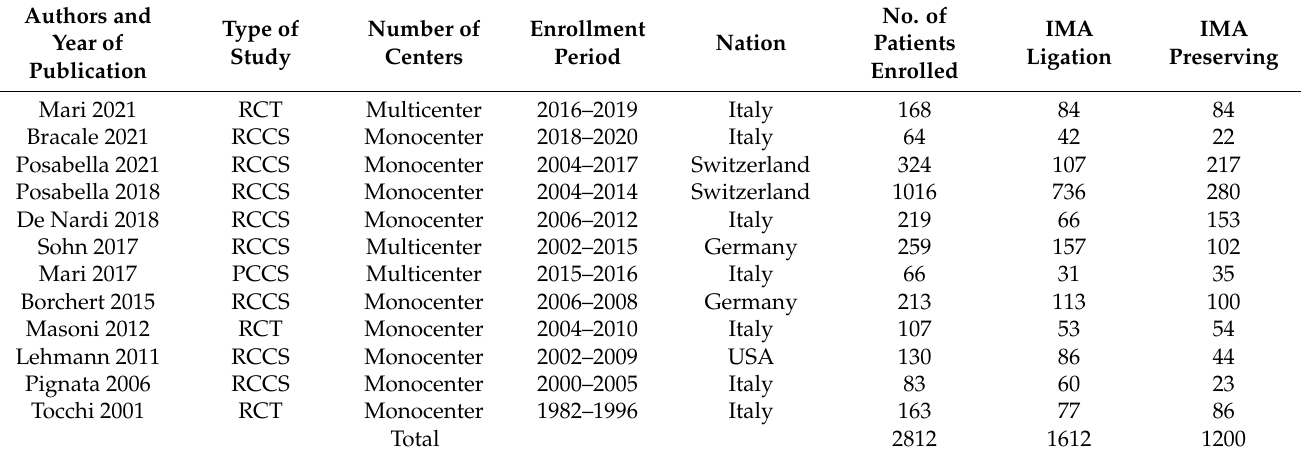
Table 1. Characteristics of studies included in the meta-analysis.